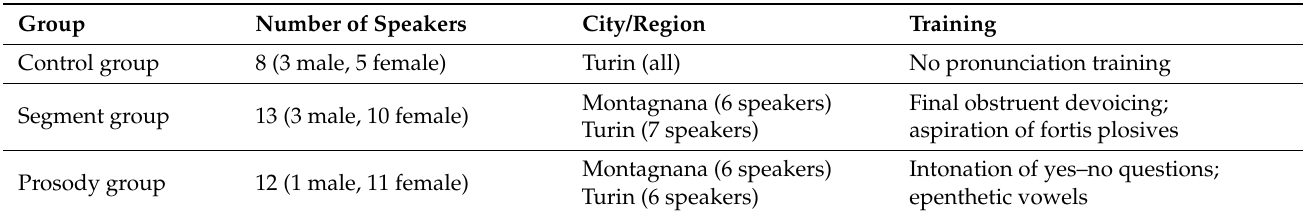
Table 1. Overview of training